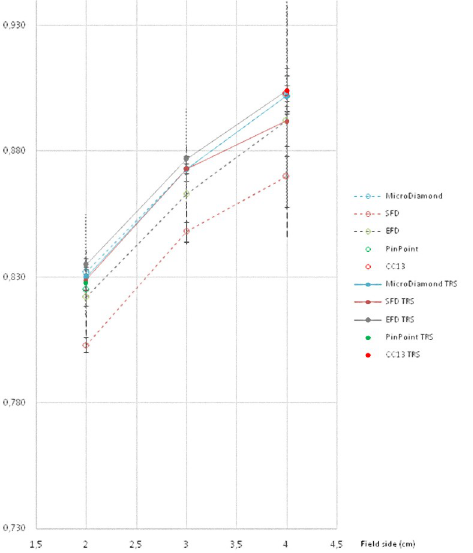
Fig 5. Ratio of detector readings and output factors for the 2 × 2 cm 2 , 3 × 3 cm 2 and 4 × 4 cm 2 fields for the 6 FFF MV beams.